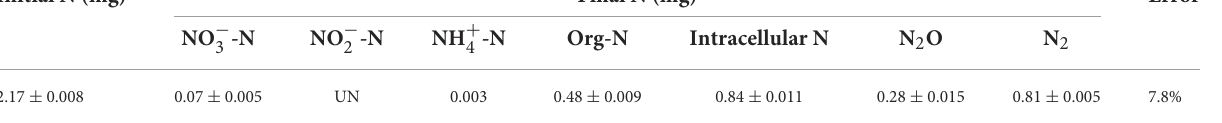
TABLE 2 The N balance of strain YC-34 after 48h